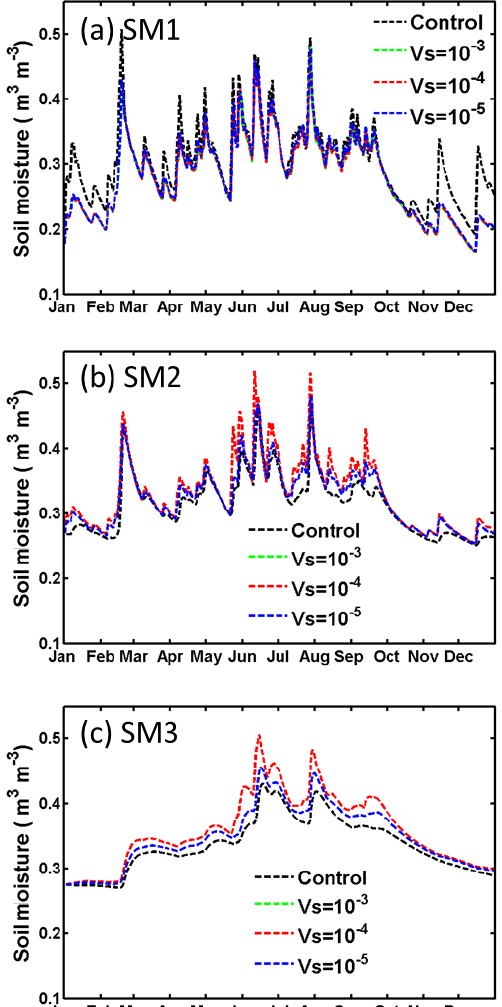
Figure 9. Sensitivity test on V s for the LHC case with optimal SLR = 90% at depths of (a) SM1 (0–20cm), (b) SM2 (20–70cm) and (c) SM3 (70–170cm). The green dashed, red dashed and blue dashed curves are for V s = 10 − 3 , 10 − 4 and 10 − 5 ms − 1 , respec- tively. Also shown by black dashed curves are the control run results (i.e., SLR =